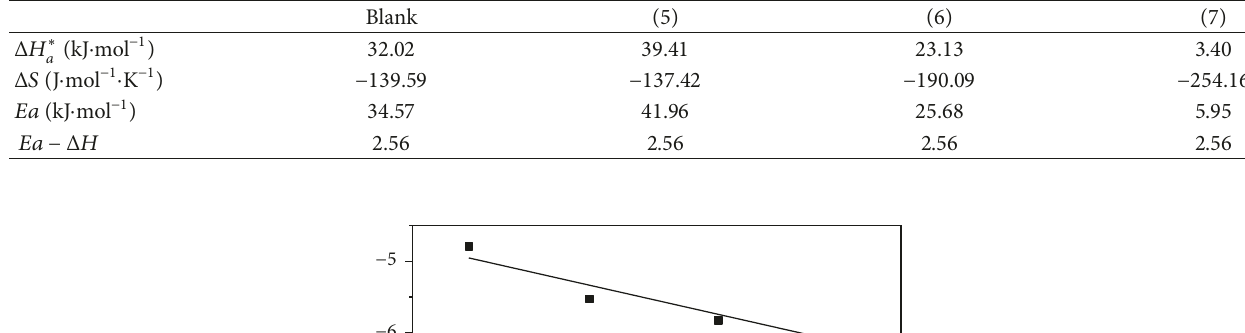
Table 6: The values of thermodynamic parameters for steel in 1MHCl in the absence and the presence of Camphor thiosemicarbazone (5) , Carvone thiosemicarbazone (6) , and Pulegone thiosemicarbazone (7) , respectively.